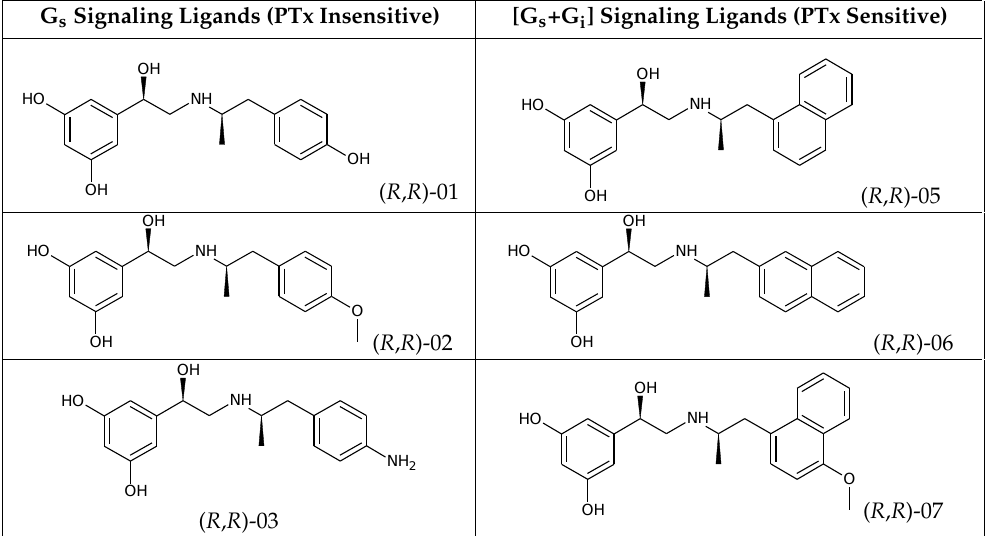
Table 1. Chemical structures of fenoterol derivatives inducing ligand directed signaling of β 2 -AR at rat cardiomyocytes, controlled by PTx [27].